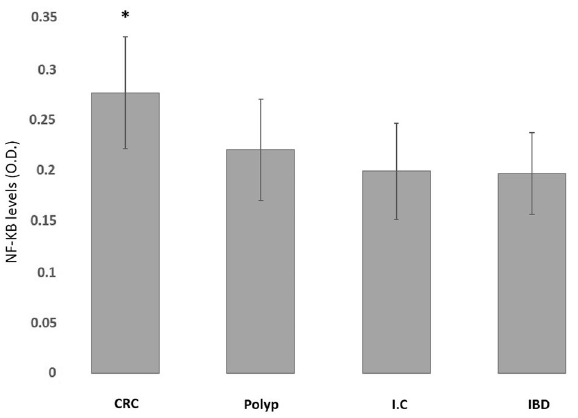
Figure 2. Comparison between NF-κB expression between cancerous tissues and all other pathologies ( p < 0.005).